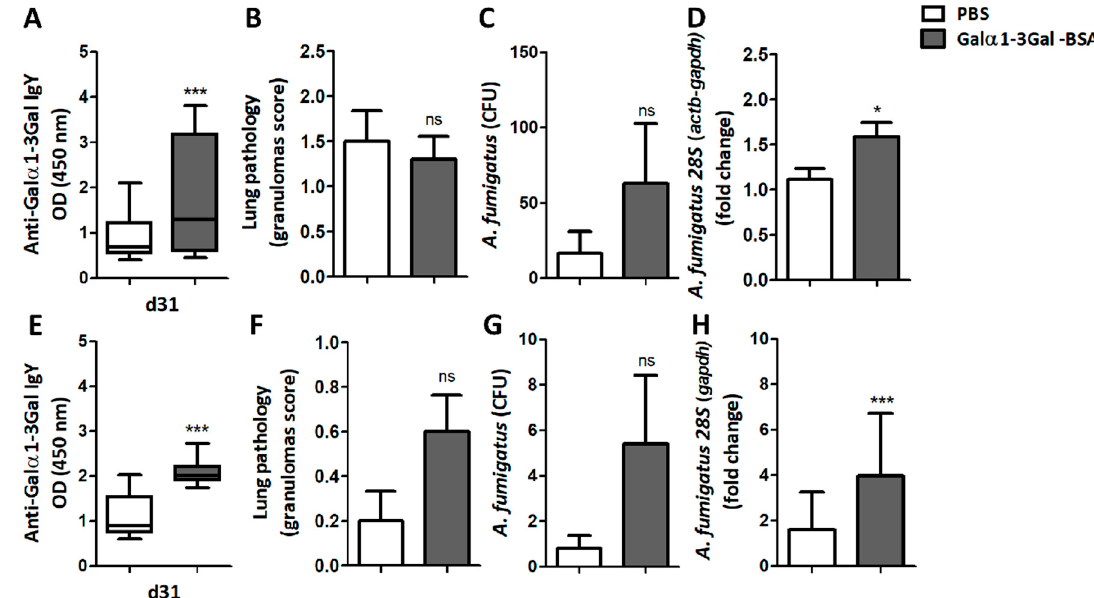
Figure 6. Immunization against α -Gal-BSA increases fungal burden in turkeys and chickens. The levels of circulating anti- α -Gal IgY Abs to Gal α 1-3Gal, lung granuloma score and A. fumigatus CFU number and 28S levels in lungs, were quantified in turkeys ( A – D ) and chickens ( E – H ). Immunization against α -Gal-BSA increases the levels of anti- α -Gal IgY Abs to Gal α 1-3Gal and A. fumigatus 28S levels in turkeys ( A , D ) and chicken ( E , H ). Results shown are means and standard deviation values. Results were compared by unpaired non-parametric Mann–Whitney U test (* p < 0.0001, *** p < 0.0001; ns: not significant, 1 experiment with chicken, n = 10 and 2 experiments with turkeys, n = 20 and three technical replicates per sample in the ELISA ( A , B ) and qPCR ( D , H )